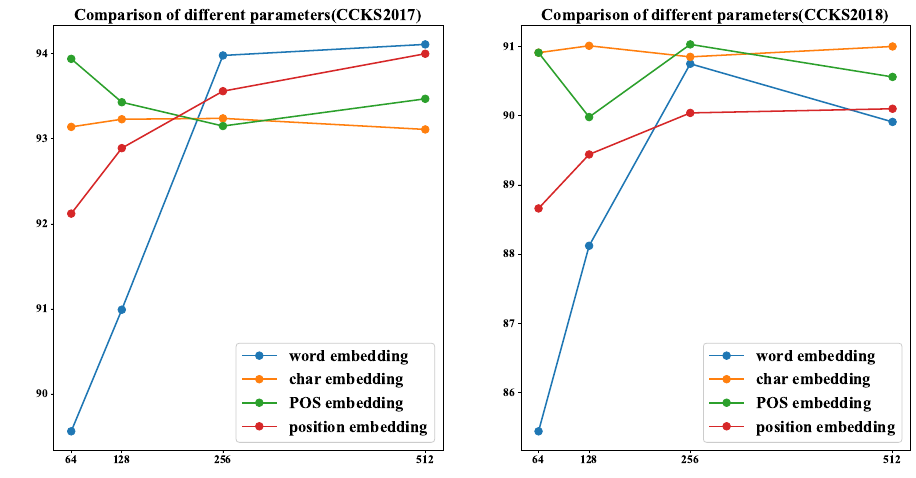
Figure 6. The chart on the left shows the effect of changes in the different embedding dimensions of CCKS2017 on the F1-score of the model (the chart on the right is CCKS2018). The abscissa represents different dimensions, and the ordinate represents the F1-score of the model on the test